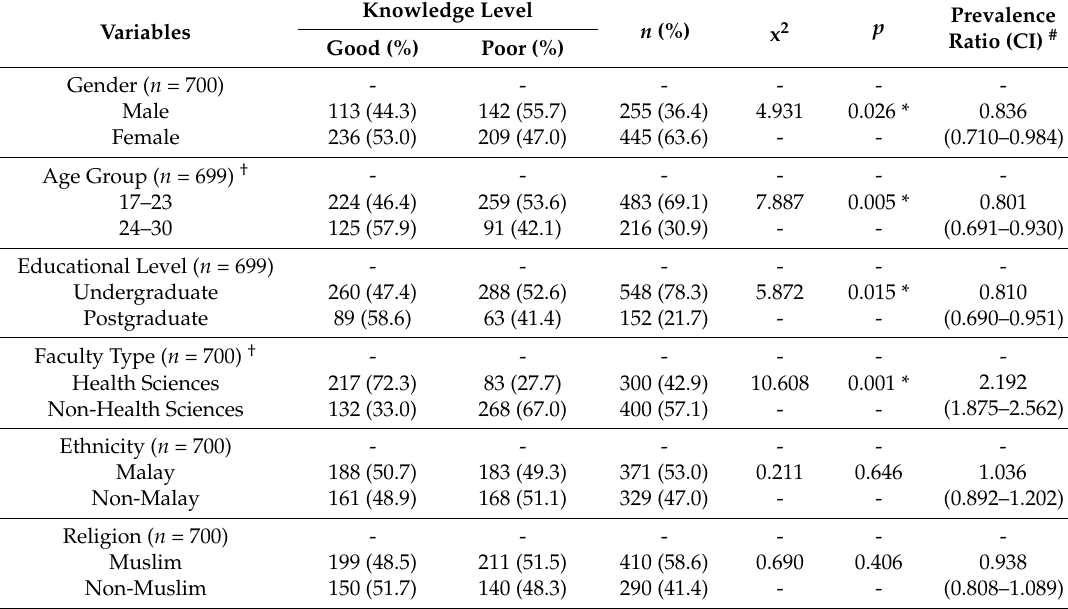
Table 5. Associations between university students’ knowledge level and their socio- demographic